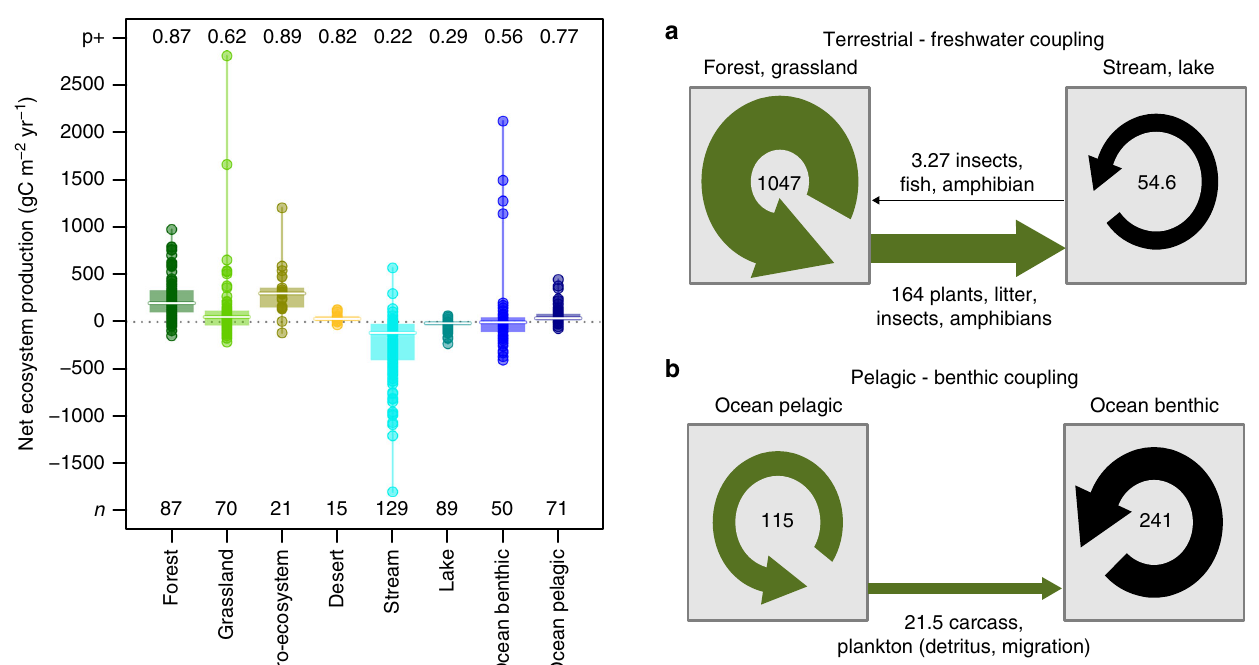
umenting these ecological blind spots is necessary to improve our ability to predict ecosystem responses to global changes across landscapes.